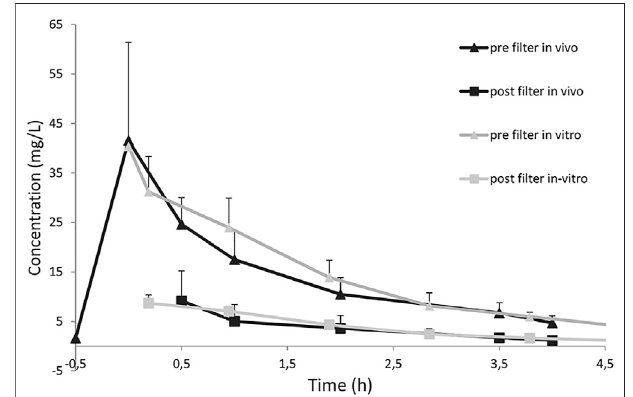
FIGURE 1 | Doripenem drug concentrations during in vivo and in vitro hemodialysis. In vitro timepoints were multiplied by a factor of 11.36 which is the ratio between Vd in vivo and in vitro . Whiskers indicate standard deviation. In vivo data has been published in 2018